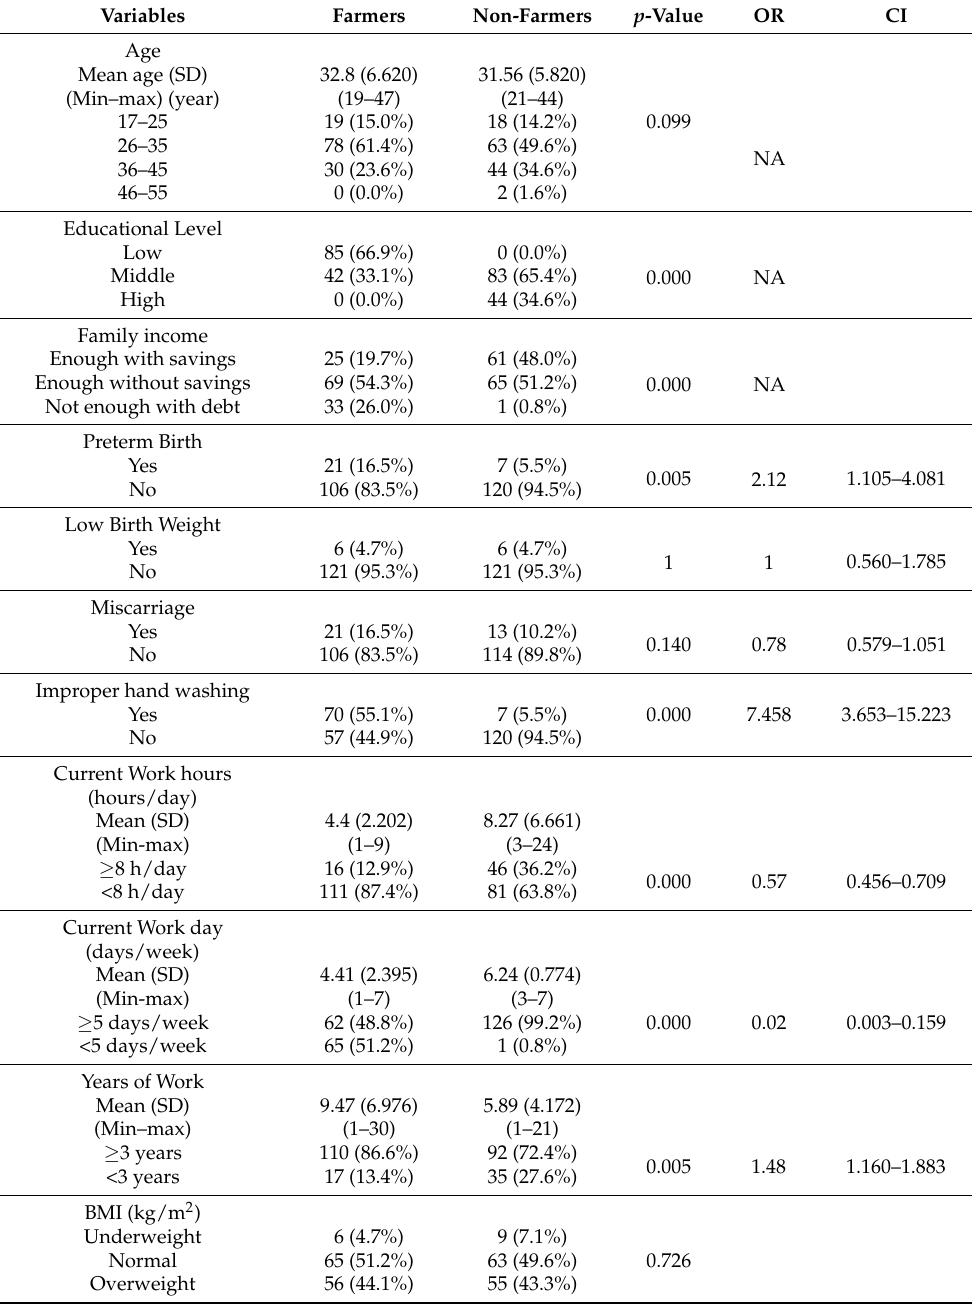
Table 1. Demographics and risk factors of farmers ( n = 127) and non-farmers ( n = 127). Variables